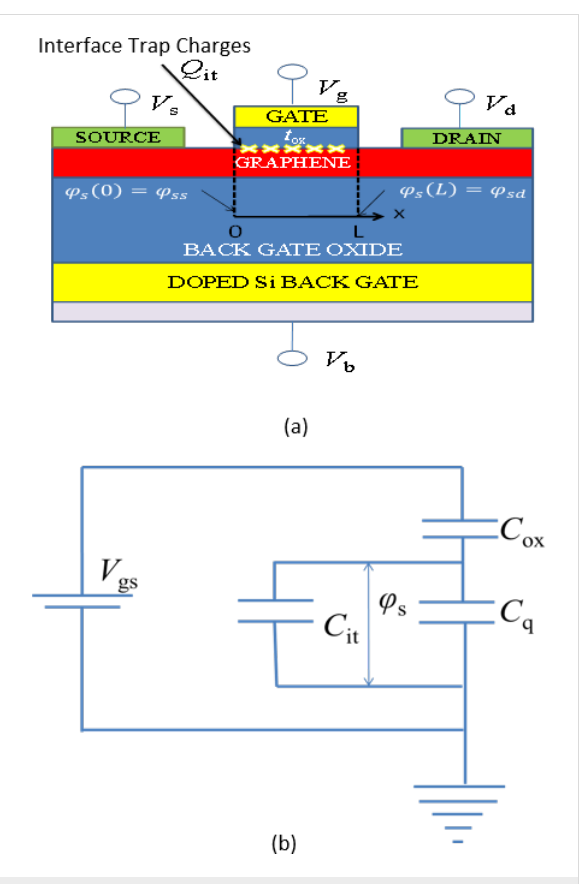
Figure 1: (a) Schematic of MOGFET device. (b) Equivalent capacitive circuit of typical capacitances in MOGFET.